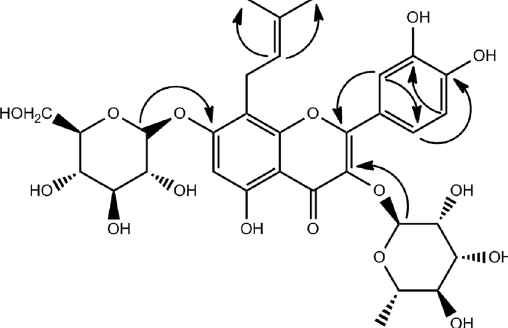
Figure 1. Key HMBC correlations of compound 1